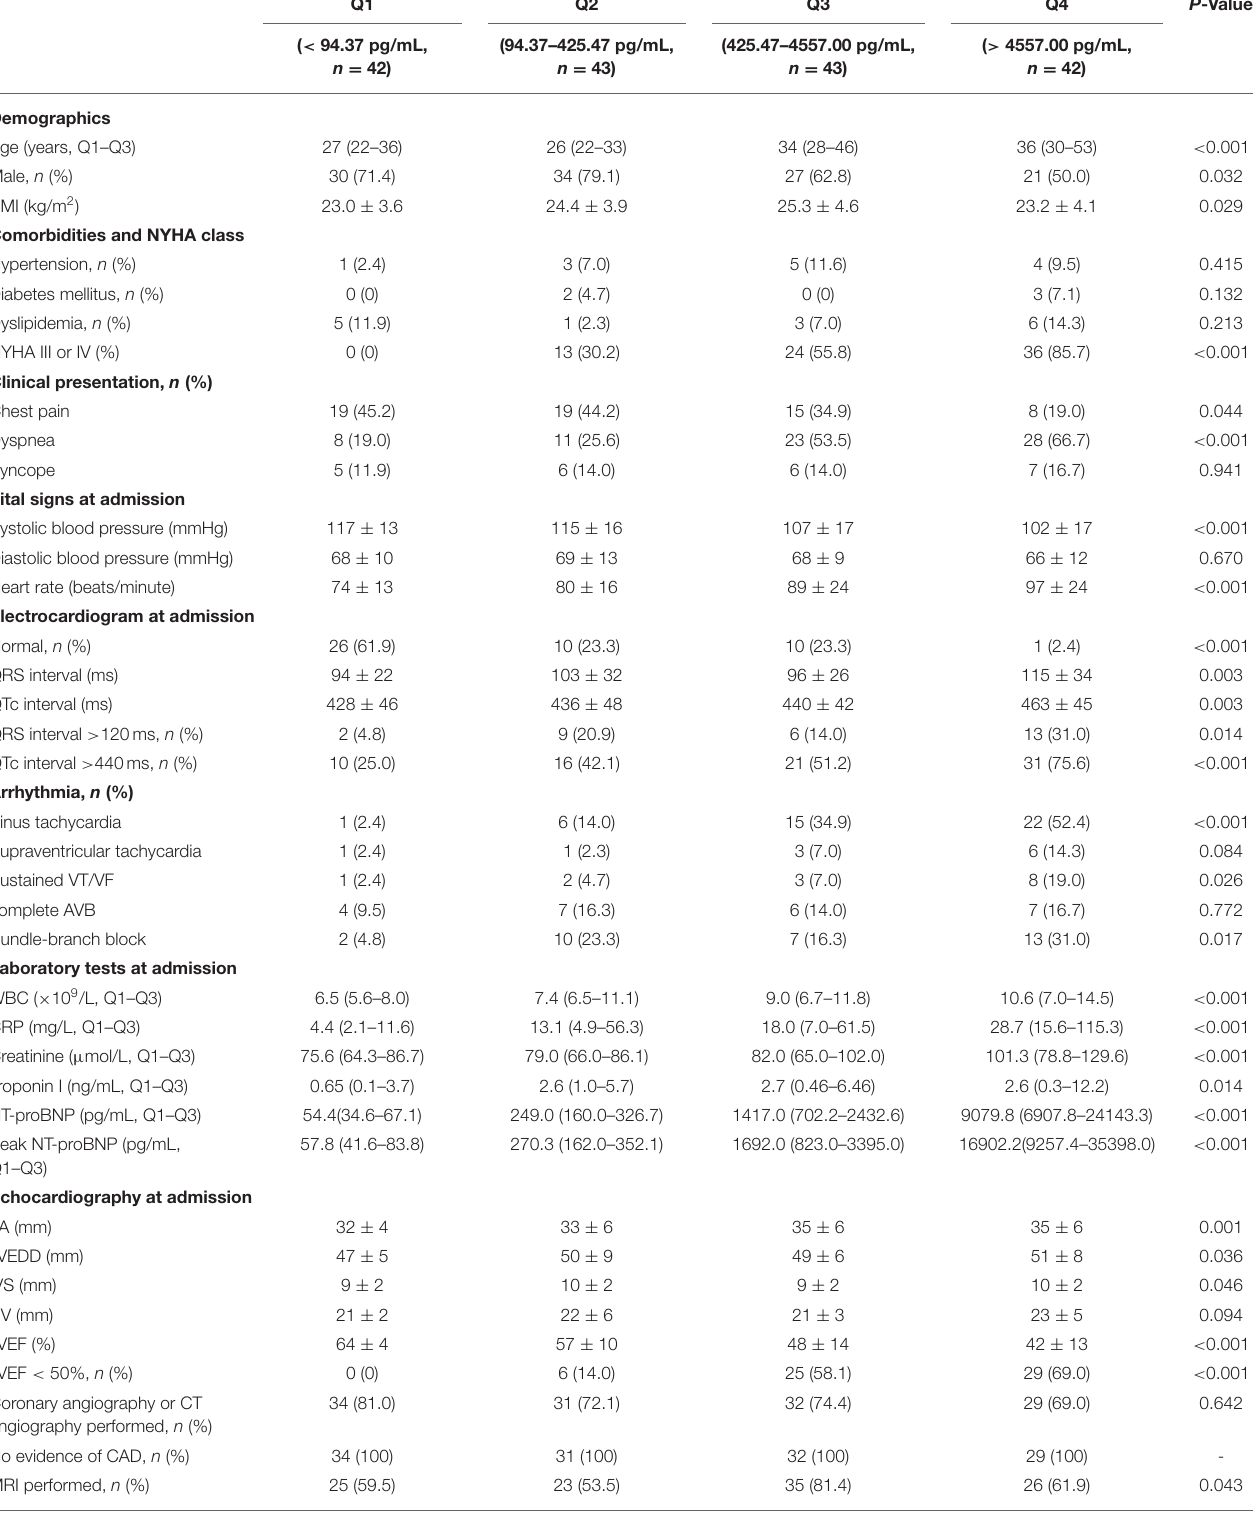
TABLE 1 | Baseline characteristics of the study population grouped by the quartiles of NT-proBNP. Q1